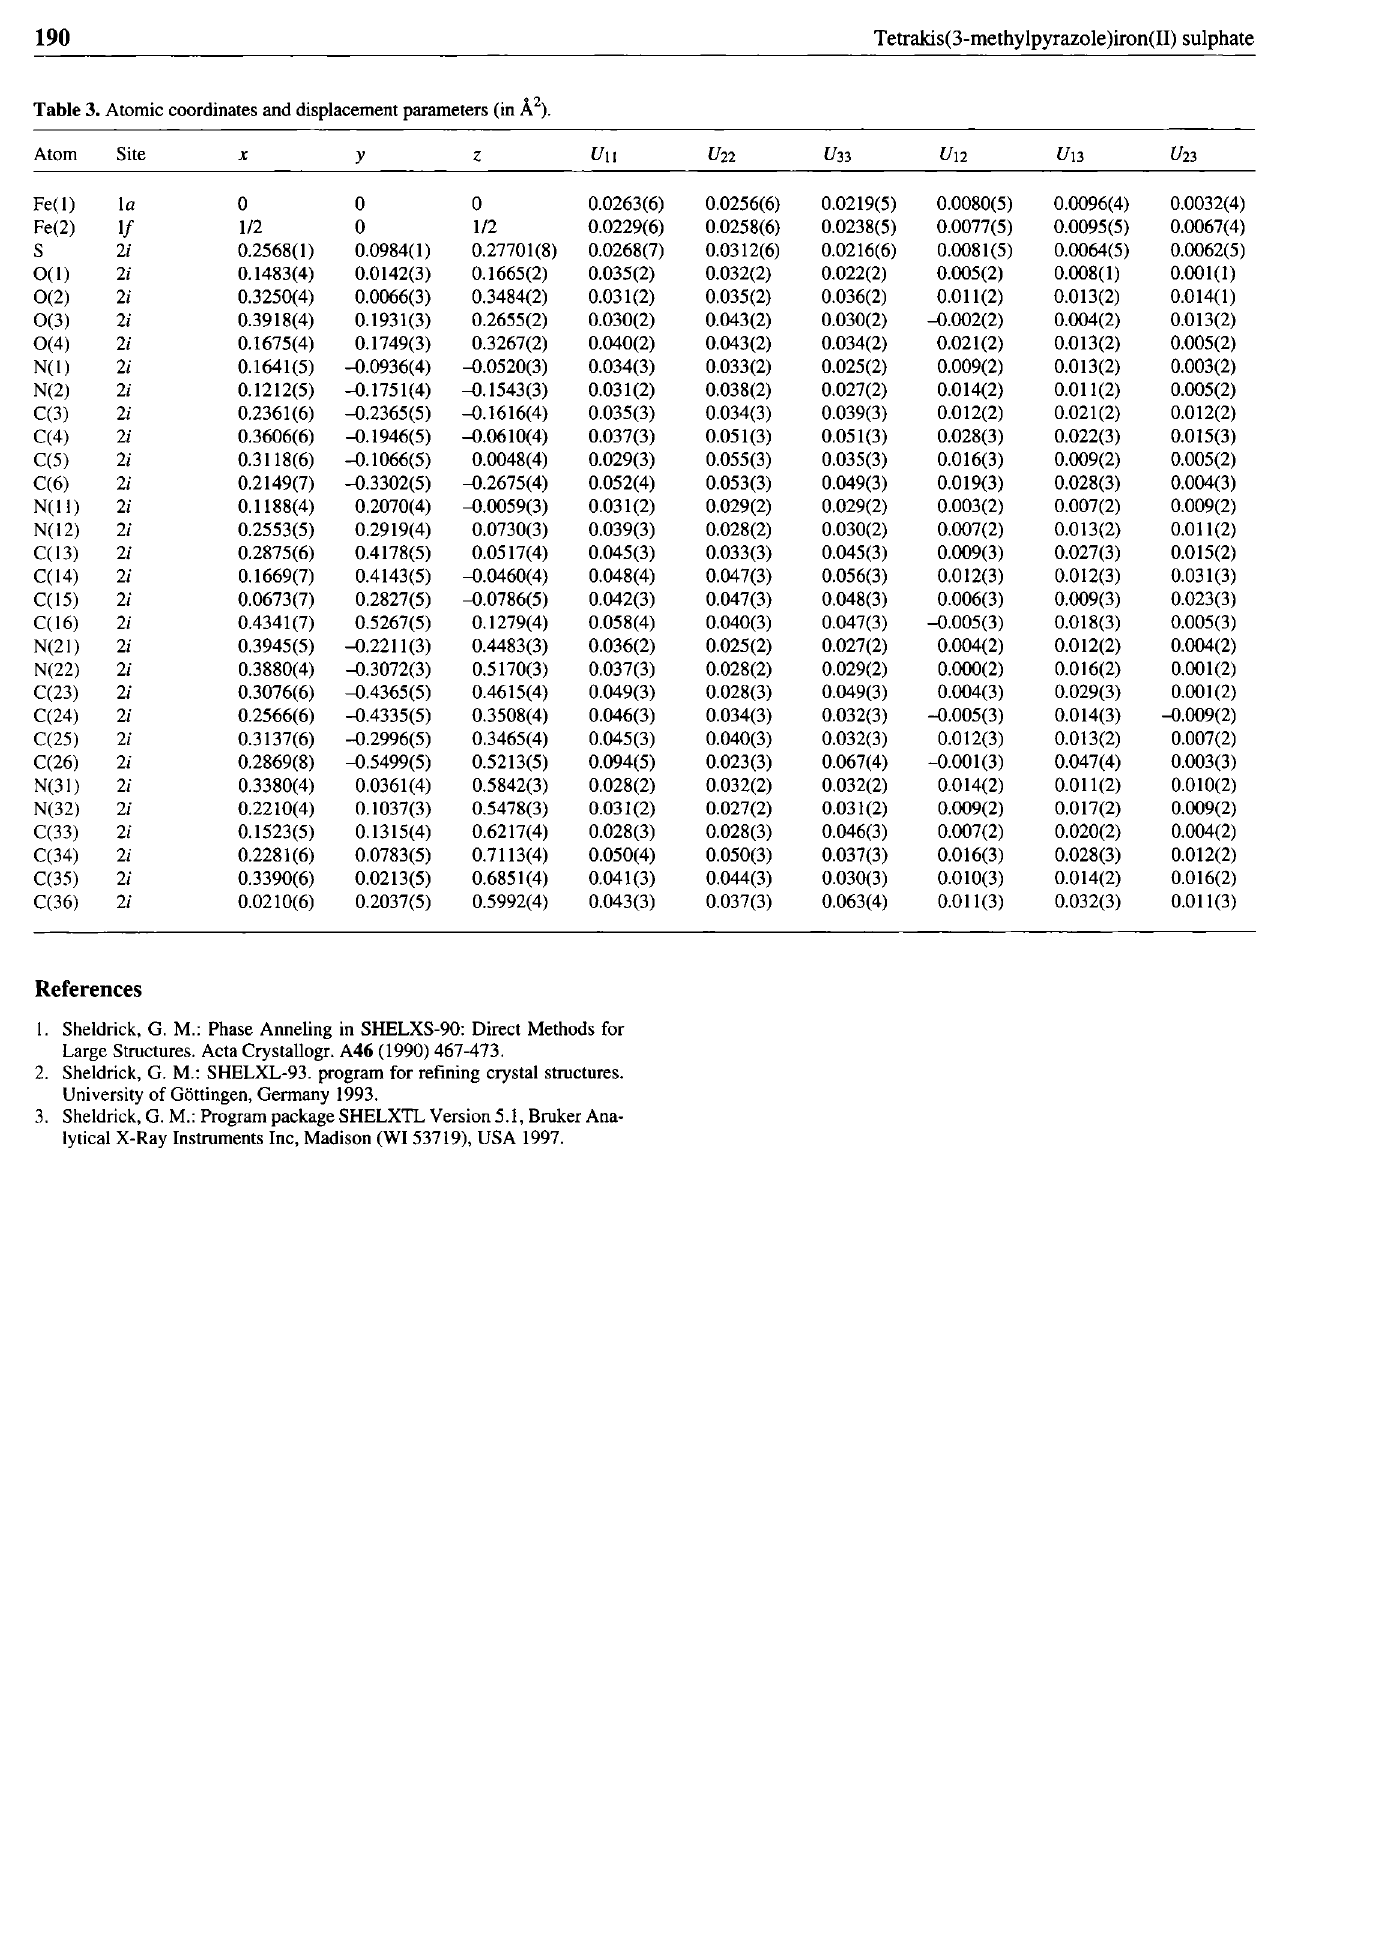
Table 3. Atomic coordinates and displacement parameters (in Ä 2